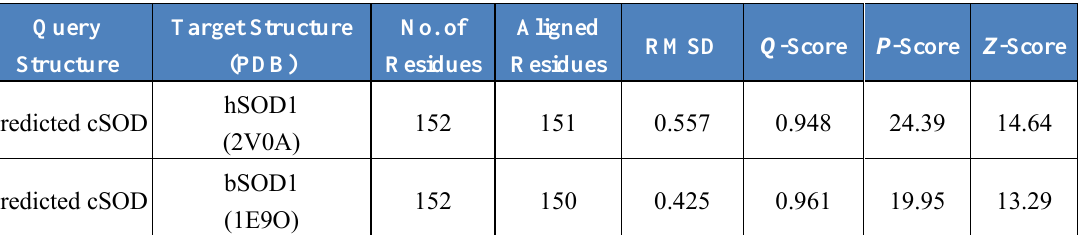
Table 3. Pairwise alignment between predicted structure of Camelus dromedarius SOD1 with Homo sapiens and Bos taurus